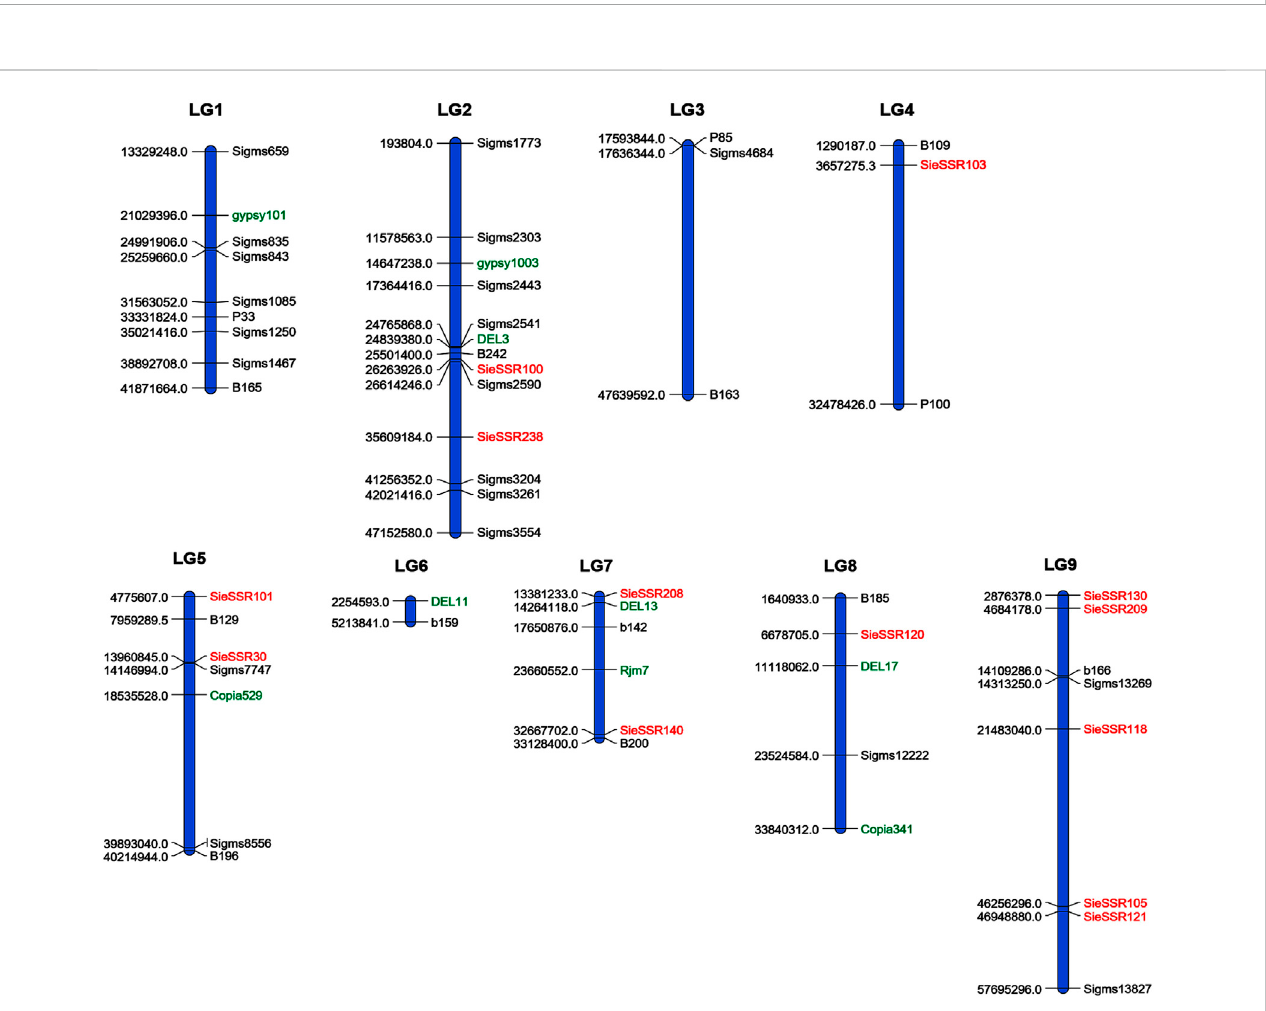
FIGURE 6 A total of 34 SSR, 21 EST SSR and 9 TE based markers dispersed across the 9 chromosomes to assess the genetic diversity in 24 foxtail millet genotypes. The markers labeled with black and red color were SSR and EST SSR markers and green color labeled markers were TE based markers.